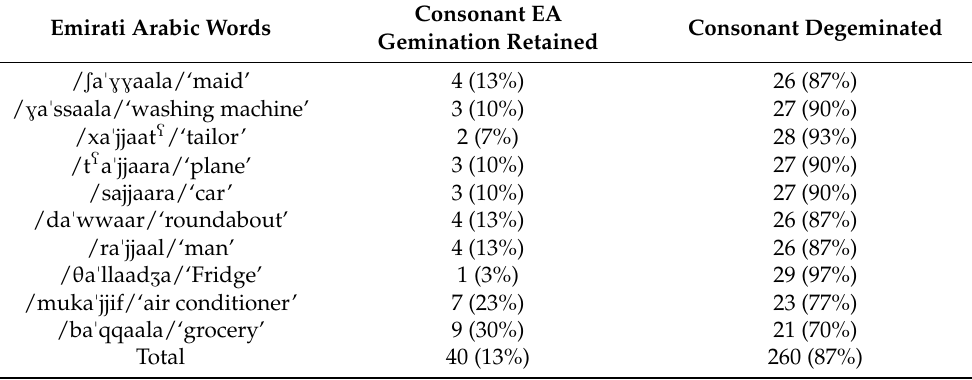
Table 3. Instances of gemination and degemination in the words of the study test by 30 participants. Consonant EA Emirati Arabic Words Consonant Gemination Retained